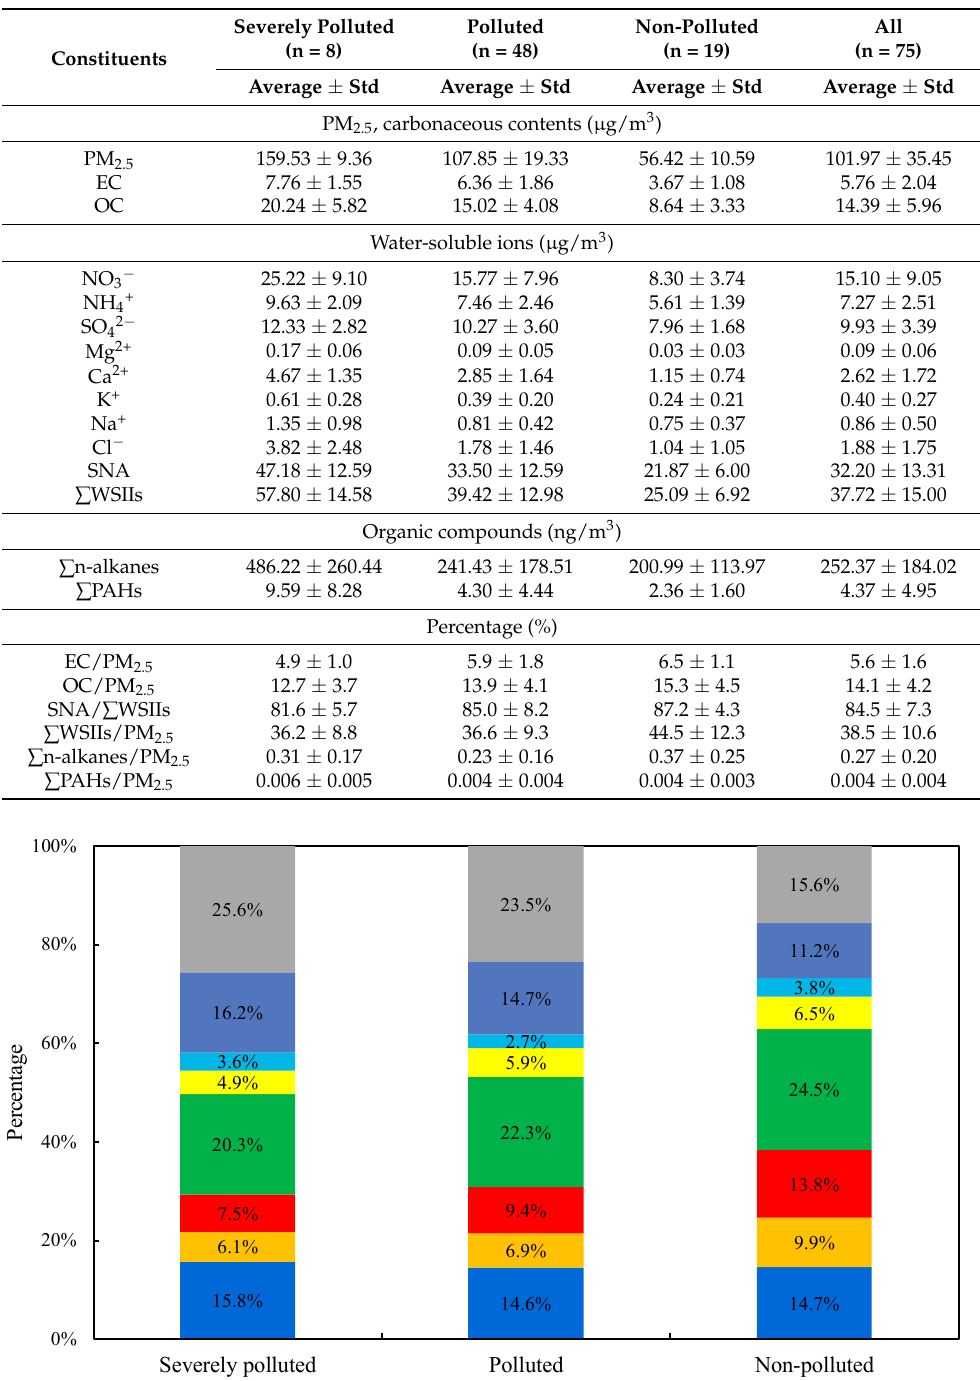
Table 1. Mean concentration ( ± standard deviation) of PM 2.5 and its major constituents in different pollution periods.